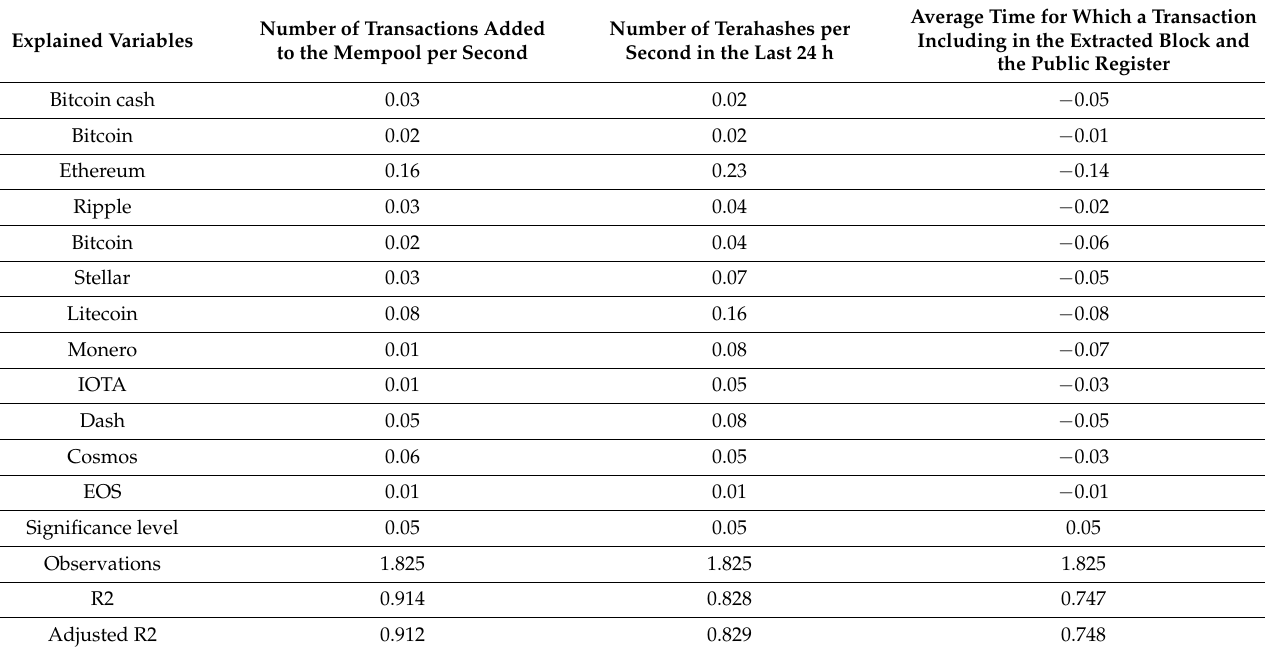
Table 4. Regression